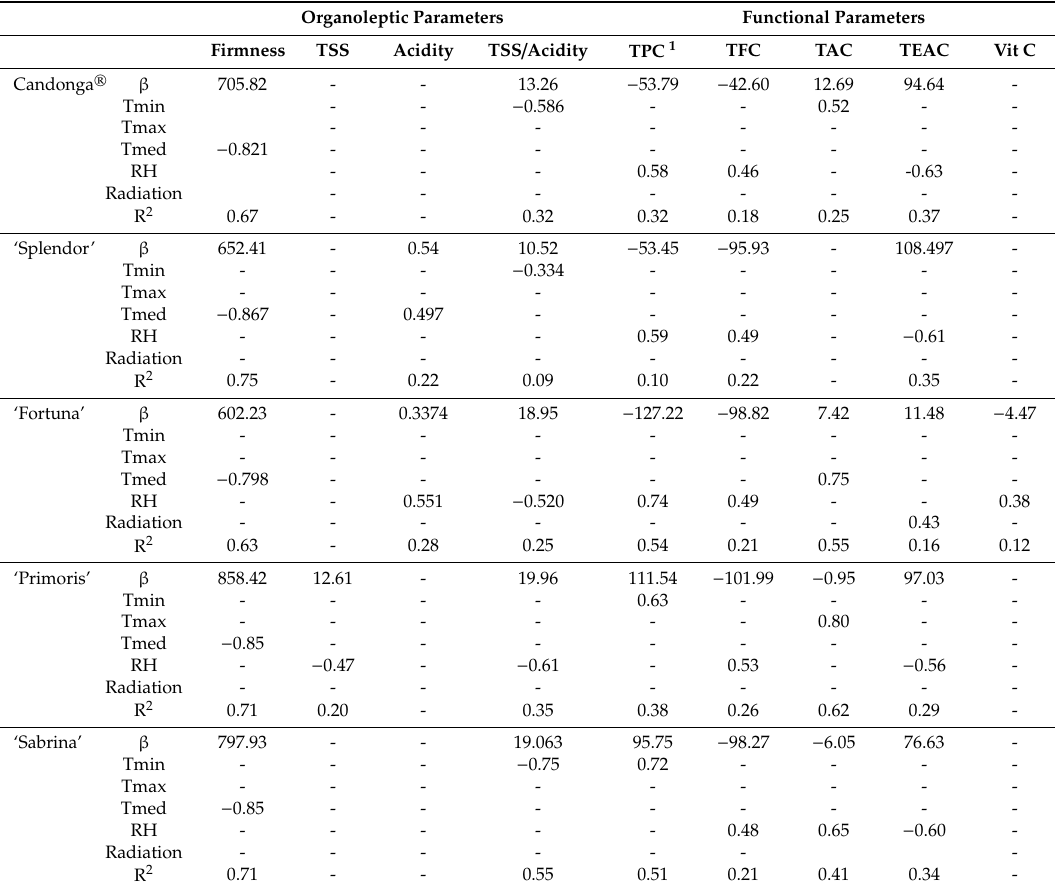
Table 4. Coe ffi cients of the fitted linear regression models (Y = aX + β ) after stepwise multiple regression between fruit quality parameters (organoleptic and functional) and environmental variables in the five varieties studied. All models fitted were significant ( p < 0.05) and the values of the coe ffi cient of determination (R 2 ) are